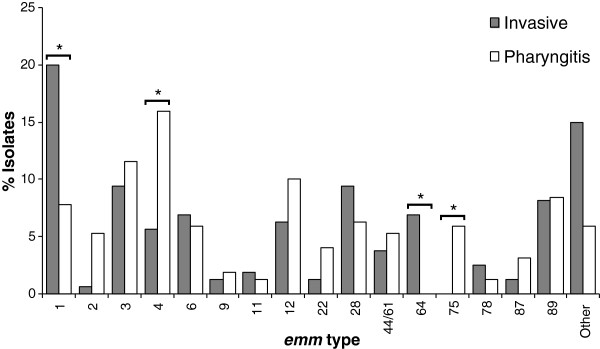
Distribution of emm types among 160 invasive isolates and 320 pharyngitis isolates. Other includes emm types identified in ≤ 5 isolates - emm18 (n=4), 25 (n=1), 29 (n=2), 30 (n=1), 43 (n=4), 48 (n=1), 53 (n=3), 58 (n=5), 74 (n=2), 77 (n=4), 90 (n=1), 94 (n=3), 102 (n=3), 103 (n=1), 113 (n=3), 114 (n=1), 118 (n=1), st106M (n=1), stG1750 (n=1), stIL103 (n=1). The asterisk indicates significant differences (P<0.001).